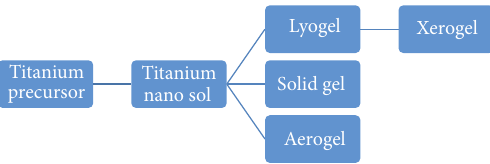
Figure 4: Different forms of titanium nanoparticles based gels at their